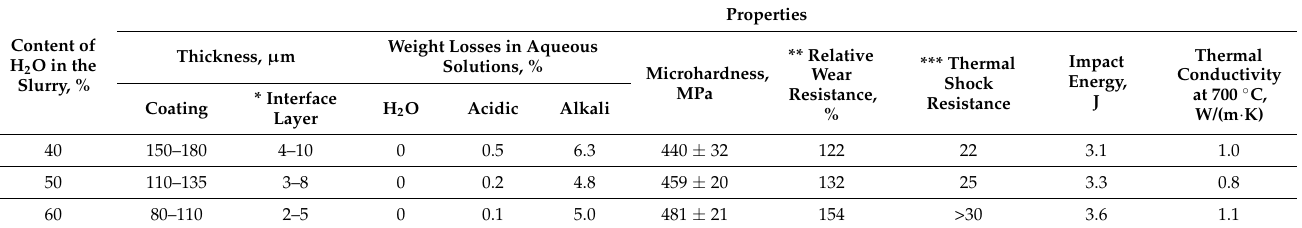
Table 5. Some properties of the protective coatings fired at 850 ◦